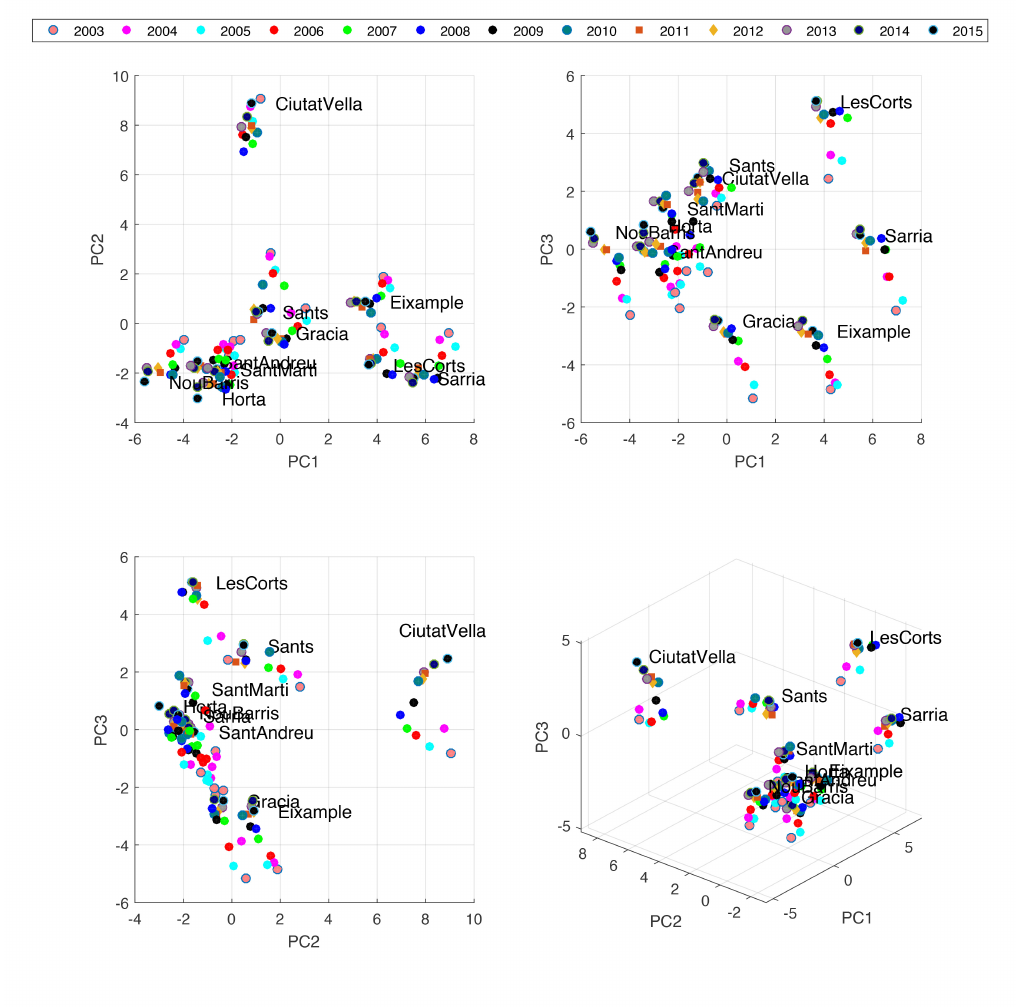
Figure 2. Three-dimensional and time-dependent data cloud from the case